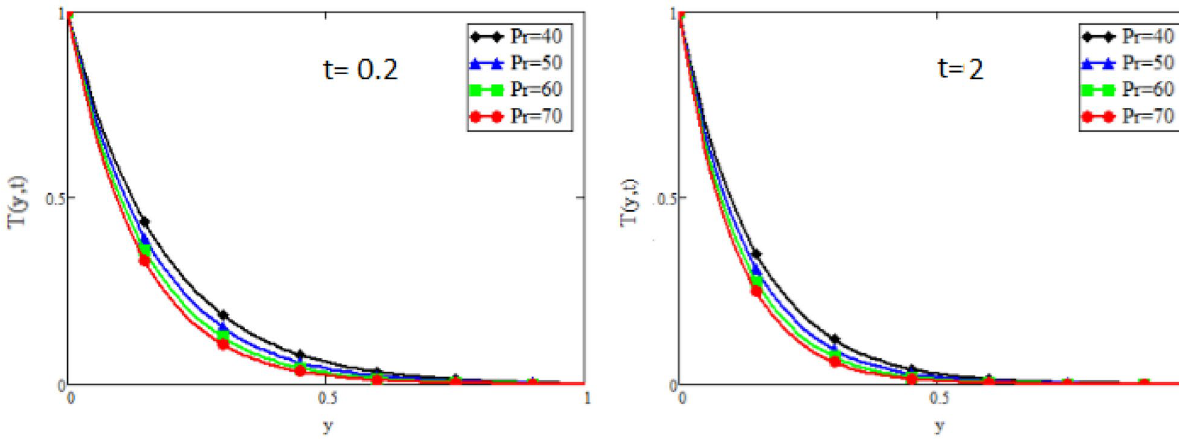
Figure 10. Impact of Pr on temperature distribution.